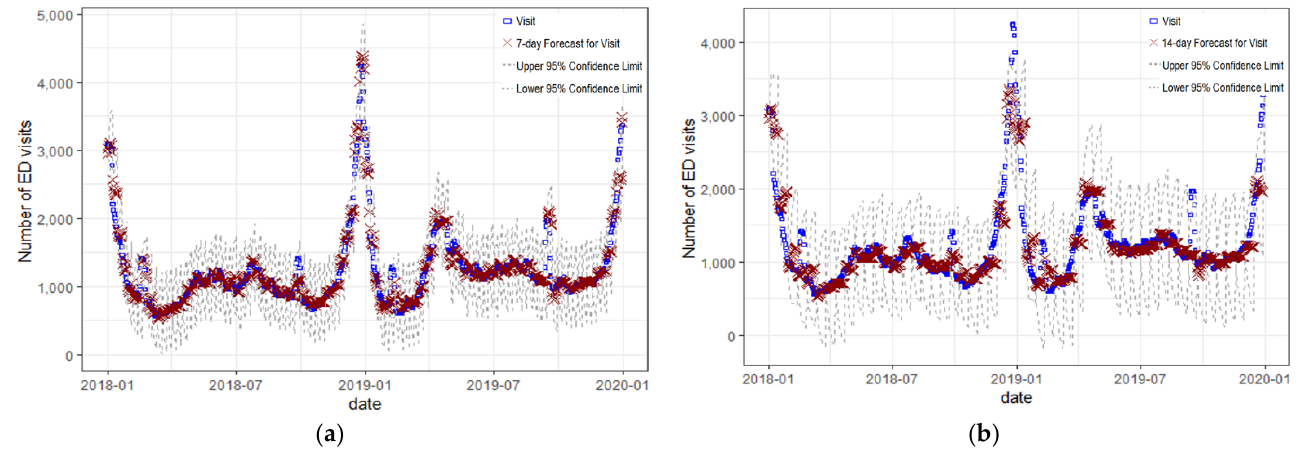
Figure 3. ( a ) The seven ‐ day moving average of ED visits with fever and the prediction of the seven ‐ day average ED visits with fever ( b ) The seven ‐ day moving average of ED visits with fever and the prediction of 14 ‐ day moving average ED visits with fever.